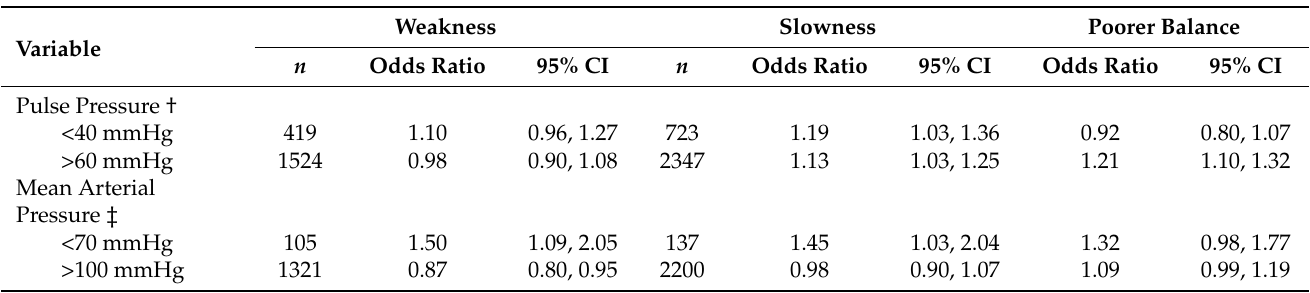
Table 4. Associations of the Individual Pulse Pressure and Mean Arterial Pressure Groups on Physical